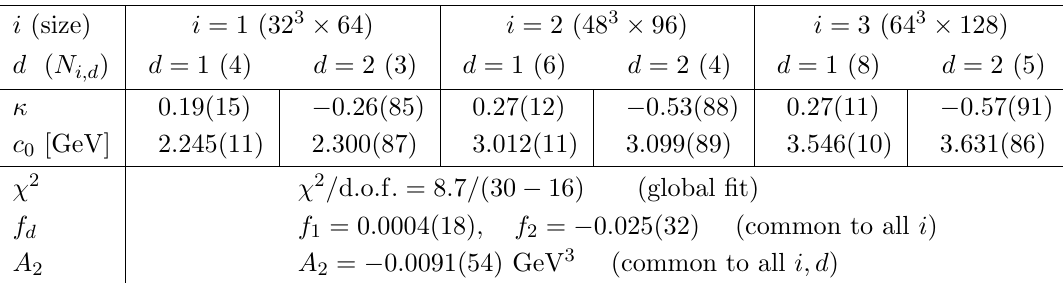
Table 6 . Fitting parameters in Analysis (II). Only statistic errors are shown. N i;d expresses the number of data points for direction d of the i -th